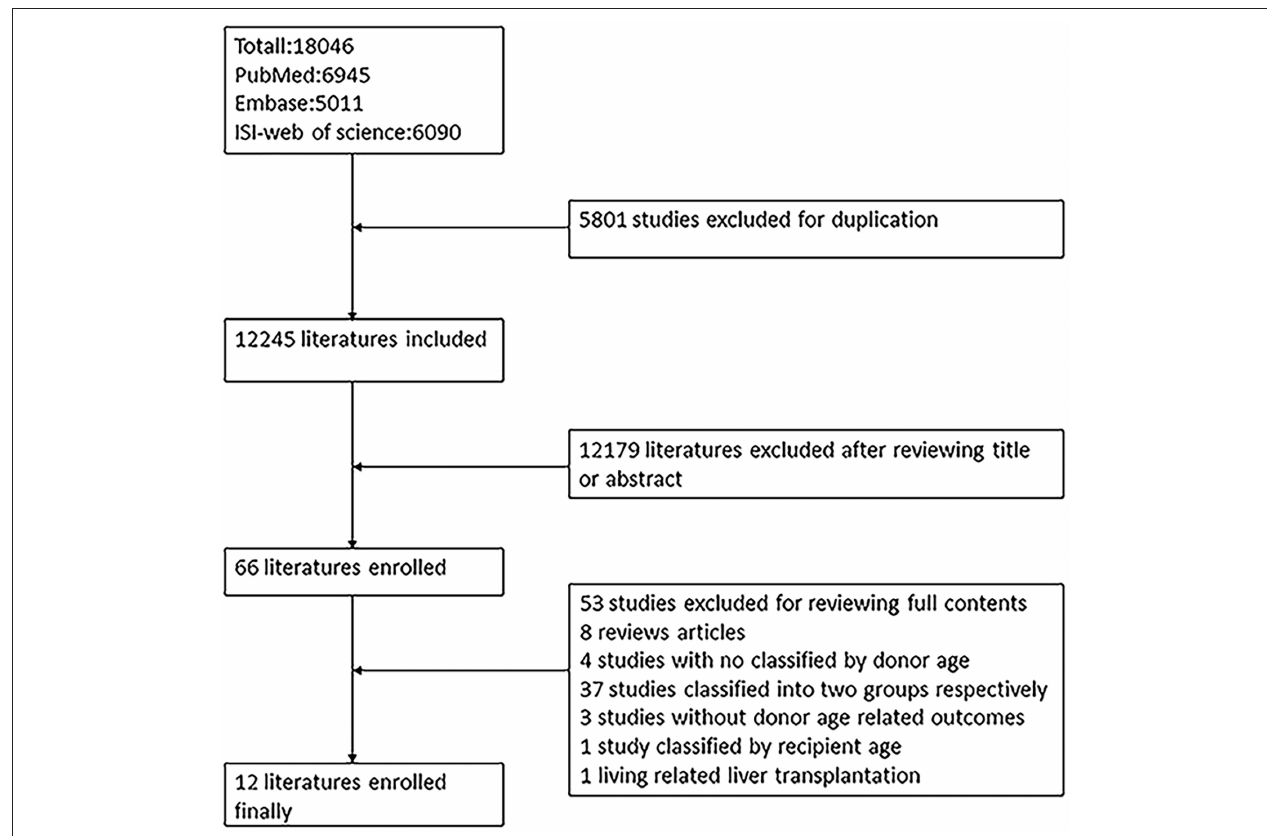
FIGURE 1 | Flow diagram on selection of eligible